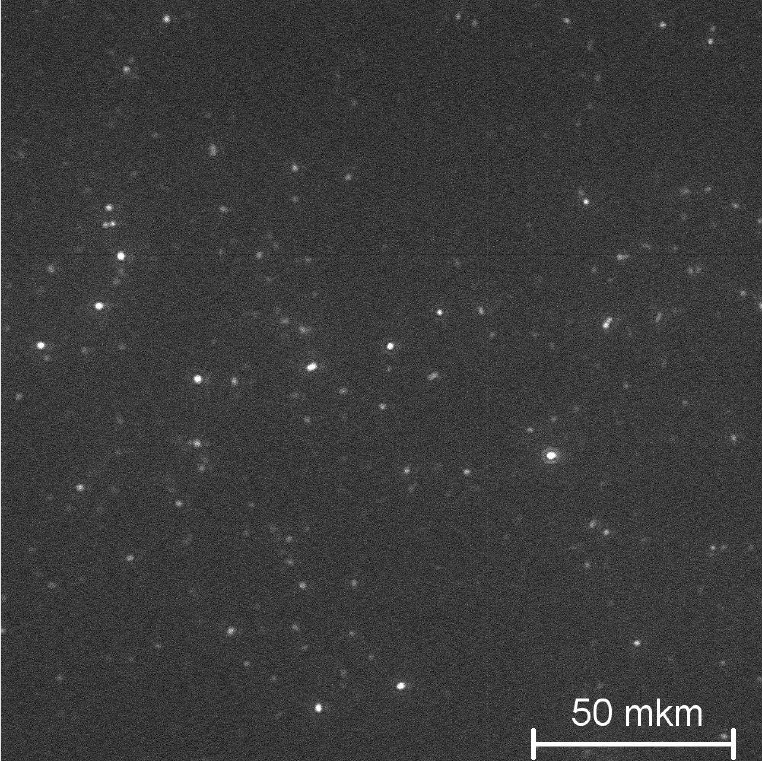
Figure 2. Example of individual images of the 0.1 at. % Nd 3+ : LaF 3 nanoparticles in an aqueous solution observed with the developed